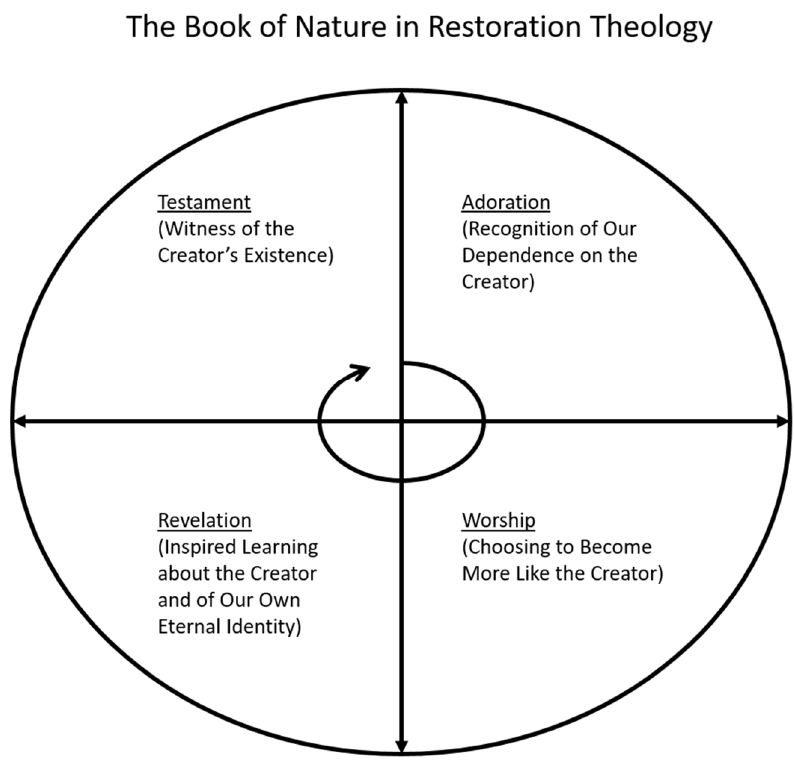
Figure 1. Kelson: Latter-Day Saint Book of Nature Hermeneutics Model.